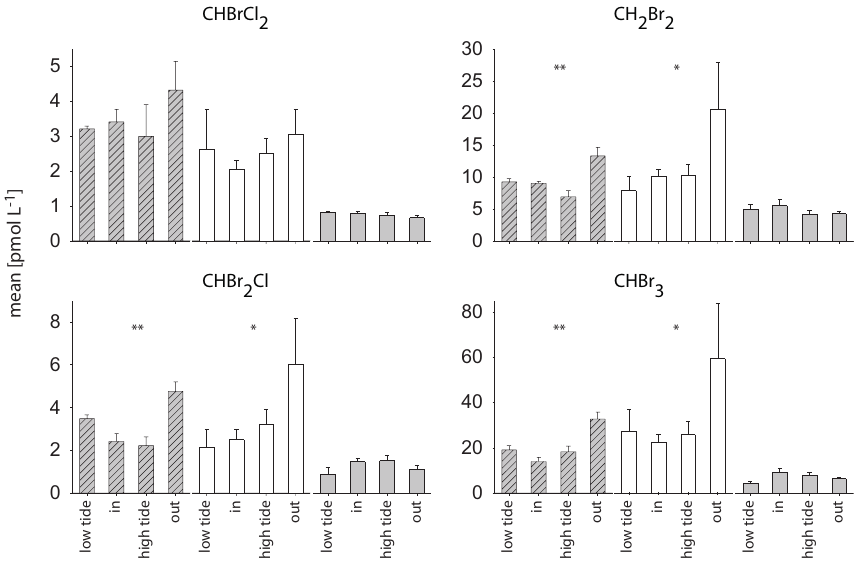
Fig. 8. Bromocarbon concentrations against tide in the upper water layers. Data are clustered into three water masses: recently upwelled waters (gray shaded), aged upwelled waters (white) and open ocean waters (gray). Mean values of four tidal steps (low tide, incoming mid tide, high tide, outgoing mid tide). Confidence levels: * significant at 90%. ** significant at